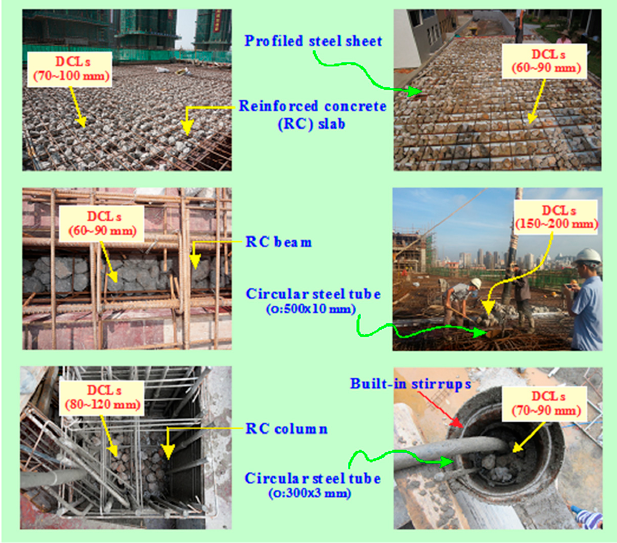
Figure 1. Applications of structural members incorporating demolished concrete lumps (DCLs).